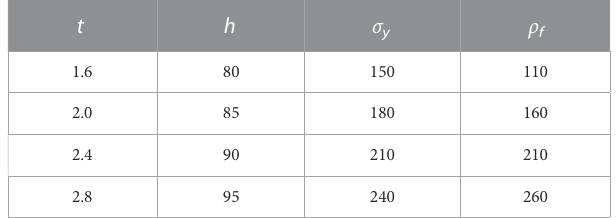
TABLE 4 Design variables